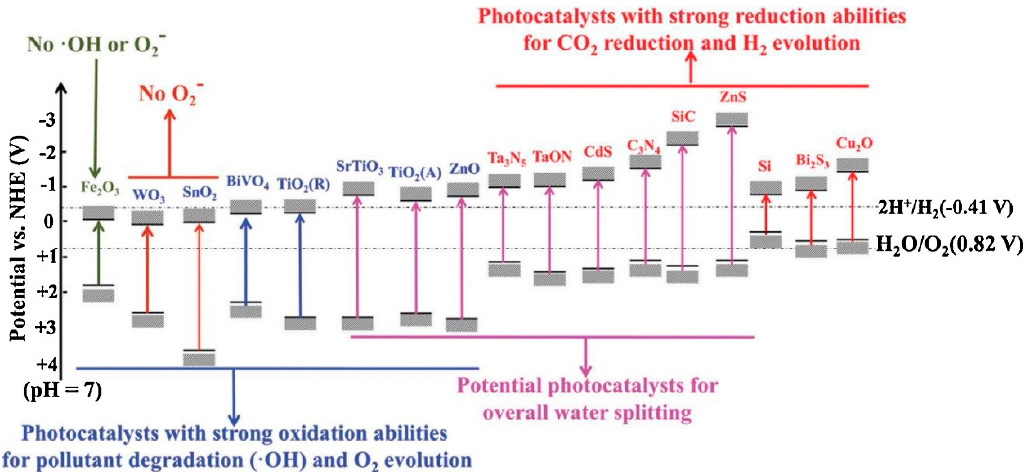
Figure 1. Band structure and potential application of various semiconductors. Reprinted from reference [38]. Copyright 2018 Elsevier.